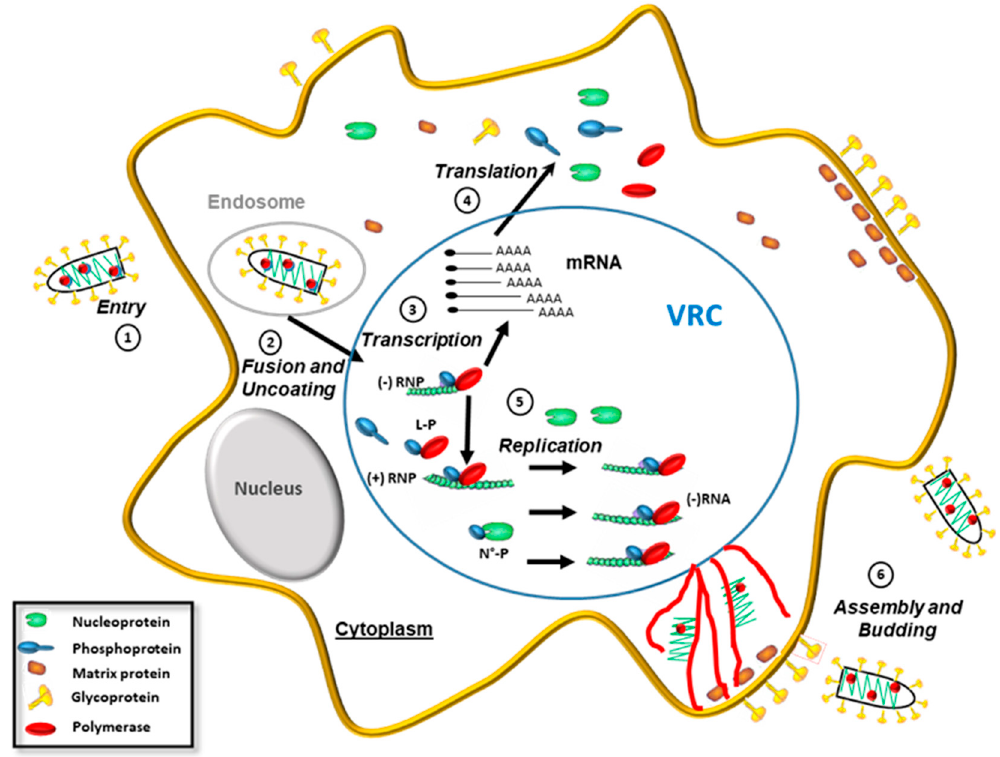
Figure 3. Rhabdoviruses life cycle. Several steps can be observed in the cytoplasm: 1. entry phase involving the binding of viral particles to receptors. 2. Endocytosis followed by membrane fusion and RNPs release in the cytosol. 3. Transcription of viral mRNA. 4. Translation of viral mRNAs by the cell machinery. 5. Replication of the viral genome and 6. transport of viral RNP by microtubules to membrane virus assembly and progeny virus budding. Viral transcription and replication occur in viral replication compartments (VRC), which are phase-separated liquid compartments.